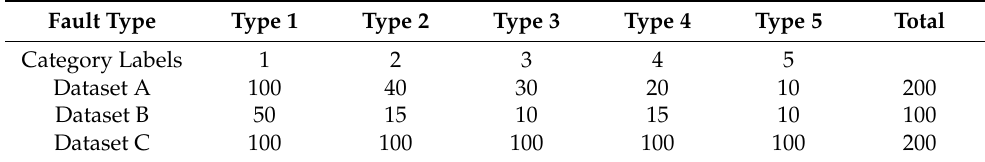
Table 5. Gear dataset with sample class imbalanced distribution.